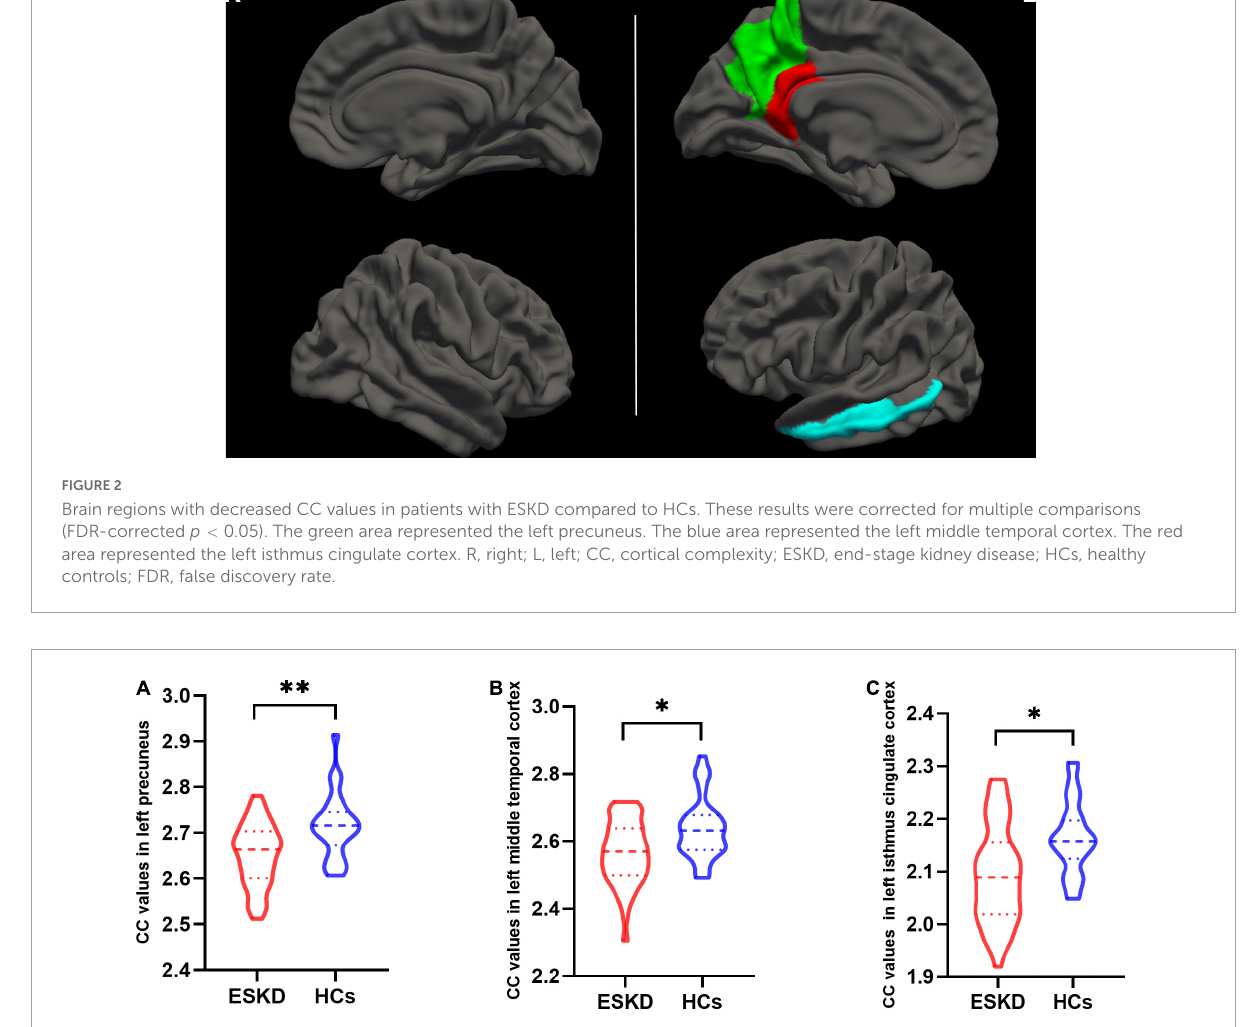
FIGURE3 The violin plot depicts group differences in cortical complexity (CC) values in brain regions between patients with end-stage kidney disease (ESKD) and healthy controls (HCs) after adjusting for age, sex, and education level. (A) The ESKD group had lower CC values in the left precuneus compared to HCs (2.65 ± 0.07 vs. 2.71 ± 0.07, false discovery rate-corrected p = 0.006). (B) The ESKD group had lower CC values in the left middle temporal cortex compared to HCs (2.57 ± 0.09 vs. 2.64 ± 0.09, FDR-corrected p = 0.010). (C) The ESKD group had lower CC values in the left isthmus cingulate cortex compared to HCs (2.09 ± 0.09 vs. 2.16 ± 0.07, FDR-corrected p = 0.018). * p < 0.05 and ** p < 0.01. CC, cortical complexity; ESKD, end-stage kidney disease; HCs, healthy controls; FDR, false discovery